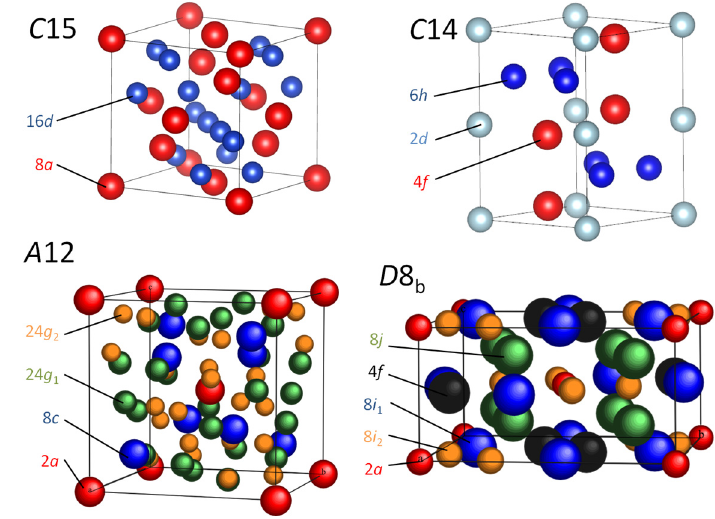
Figure 4. Structure drawing of the phases discussed in the following.